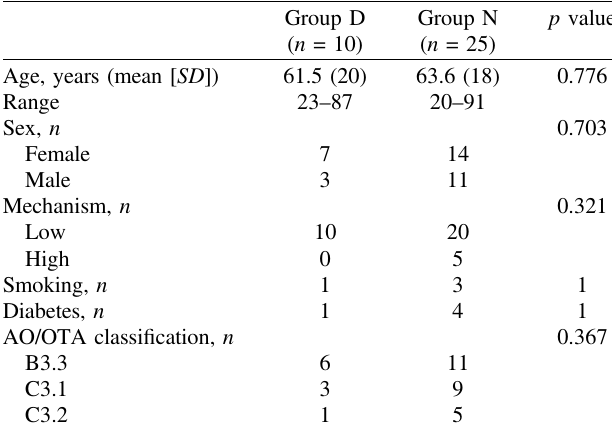
Table 1. Patient